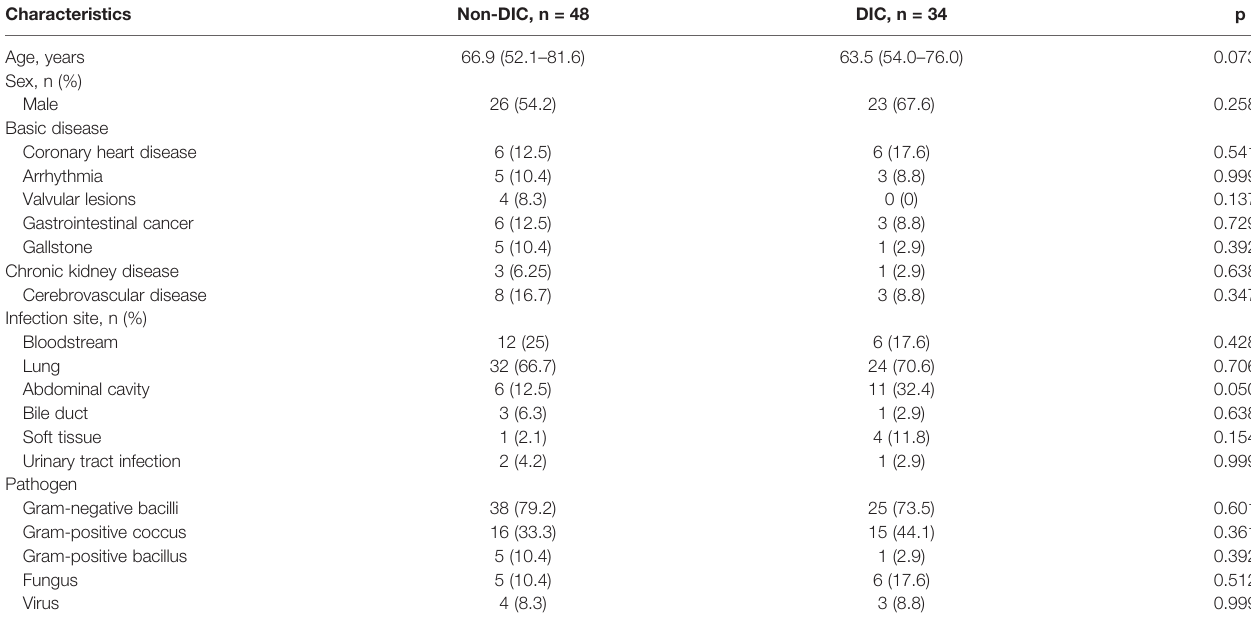
TABLE 1 | Baseline characteristics of the patients included.